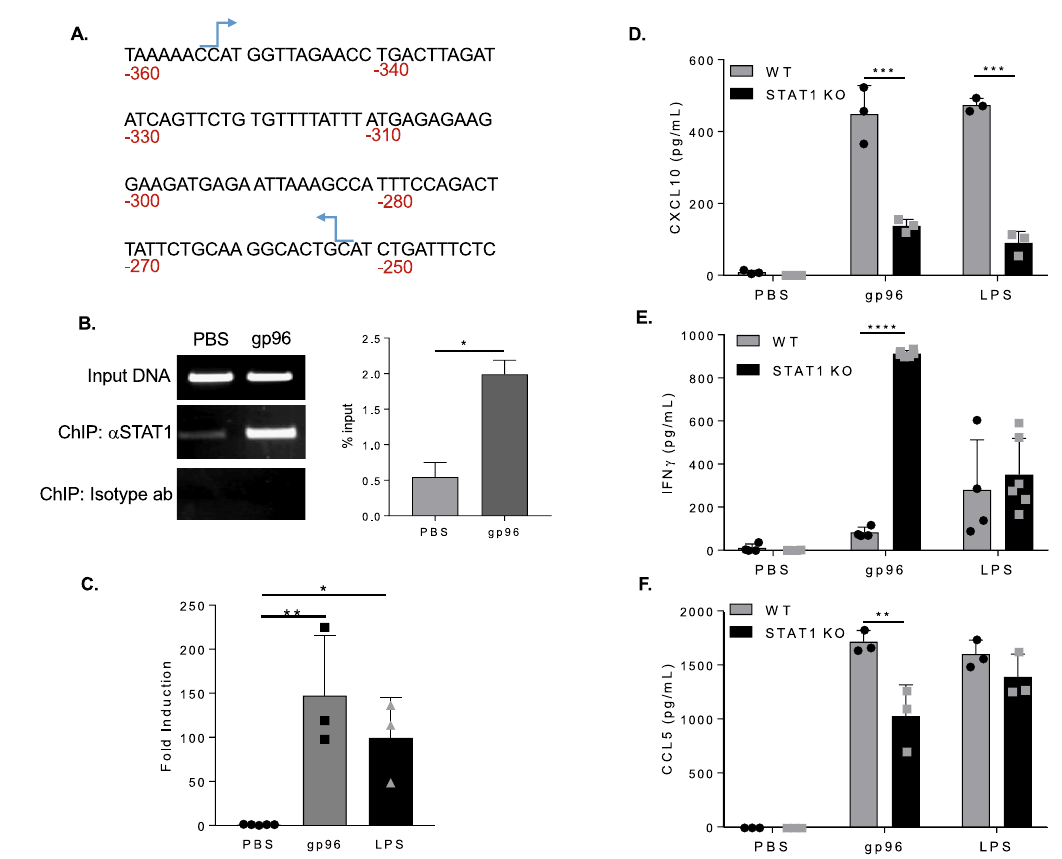
Figure 4. STAT1 is required for CXCL10 production by PECs. (A and B) PECs were treated with 200 µ g/mL gp96 for 1 h. STAT1-bound DNA was isolated by ChIP from cell lysates. Isolated DNA was amplified by RT qPCR for CXCL10 (A) Illustration of the promoter region of CXCL10. Primers sites used for amplification are indicated by the arrows. (B) Percent input was calculated for 3 independent experiments and also analyzed on an EtBr gel. (C) PECs were treated with 200 µ g/mL gp96 for 8 h. Cells were lysed and RNA was harvested for qRTPCR. Fold change in expression of CXCL10 mRNA was determined relative to the PBS treated sample in each cell type. (D) WT or STAT1 KO PECs were activated with 200 g/mL gp96 for 24 h. Supernatants were assayed by ELISA for the secretion of CXCL10. (E) WT or STAT1 KO PECs were co-cultured with WT NK cells in the presence of 200 μg/mL gp96. IFN- γ secretion was measured by ELISA. (F) WT or STAT1 KO PECs were treated as (D) and CCL5 release was measured by ELISA. Data in the graphs data are pooled from 3 independent experiments. Data are represented as mean ± s.d. ns not significant, *p < 0.05, **p < 0.01, ***p < 0.001 (student’s t-test used in panel B; one-way ANOVA with Sidak’s multiple comparison test used in panel CCL5 release was significantly decreased in STAT1 KO PECs (Fig. 4F), suggesting that lack of STAT1 leads to an extensive dysregulation of multiple factors that influence NK cell activation. Gp96‑mediated signaling activates STAT1 via p38. STAT1 stress-inducers such as LPS, UV irradia- tion, and TNF- α , generally signal STAT1 S727 phosphorylation through p38 25 . We investigated the role of p38 in STAT1 phosphorylation in the response of PECs and BMDCs to gp96. PECs and BMDCs were activated with gp96 for 20 min, upon which they were harvested and probed for p-p38 and total p38. Similar levels of p38 phosphorylation were observed in PECs (Fig. 5A,B) and BMDCs (Fig. 5C,D). We confirmed this observa- tion in spDCs. Similar levels of p38 phosphorylation were detected in spDCs following stimulation with gp96 (Fig. 5E,F). LPS was used as a positive control for p38 phosphorylation in all 3 cell types. We tested the depend- ence of STAT1 phosphorylation on p38 by using the inhibitor SB203580. We assessed the phosphorylation of STAT1 S727 in PECs at 20 min (Fig. 5G,H) and BMDCs at 120 min (Fig. 5I,J). These time points are the ear- liest times at which we observe S727 phosphorylation in PECs and BMDCs respectively. STAT1 S727 phos- phorylation in PECs and BMDCs following stimulation with gp96 was inhibited by SB302580 (Fig. 5H,J). The mechanism of STAT1 Y701 phosphorylation in response to stress-inducers is yet undefined and it is not known whether this is controlled by p38. To determine if phosphorylation of Y701 in response to gp96 is p38 mediated, we also measured Y701 phosphorylation in PECs in the presence of SB203580. Gp96-mediated phosphorylation of Y701 was also inhibited by SB203580 (Fig. 5K,L). Importantly LPS-mediated phosphorylation of Y701 was